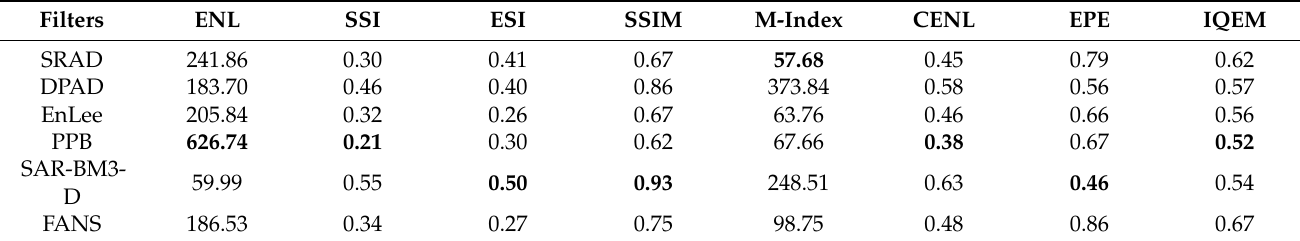
Table 5. Index evaluation of the Sentinel-1 SAR